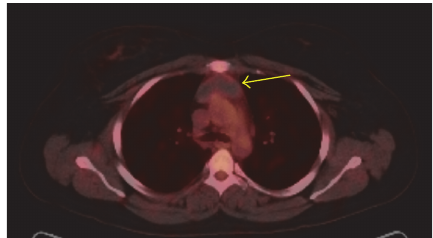
Figure2:Sagittalreconstructionshowsthesamemassinthevertical plane (red arrow).